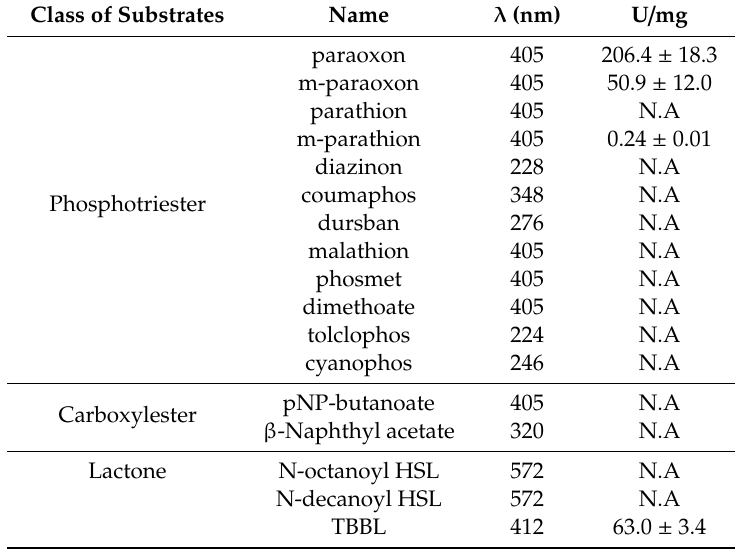
Table 1. Specific activities of 4Mut on phosphotriesters, carboxylesters and